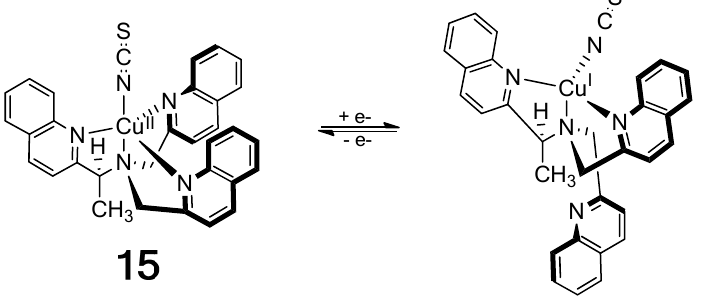
Figure 17. On/off chiroptical molecular switch: One-electron reduction of a Cu 2+ complex results in dissociation of an arm of the chiral tripodal ligand [79]. Reproduced by permission of